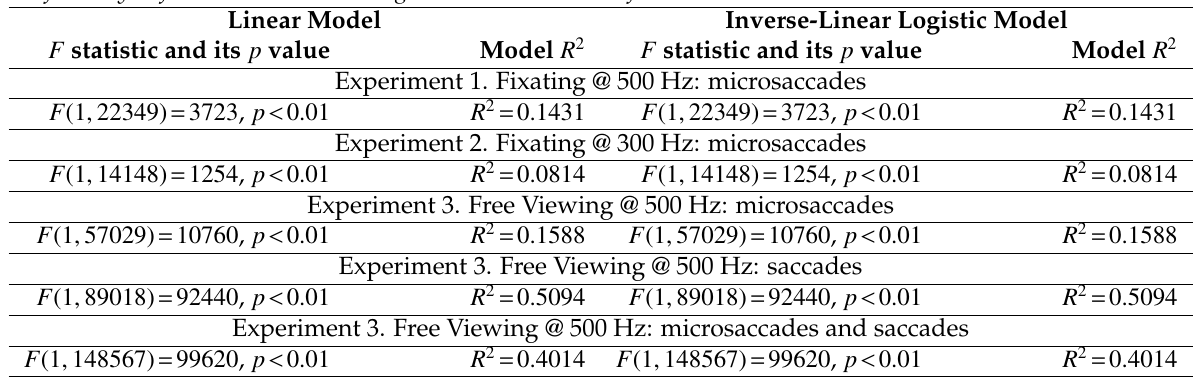
An Inverse-Linear Logistic Model of the Main Sequence